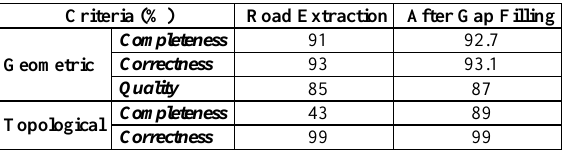
Table 1. Evaluation of extracted network in the first experiment